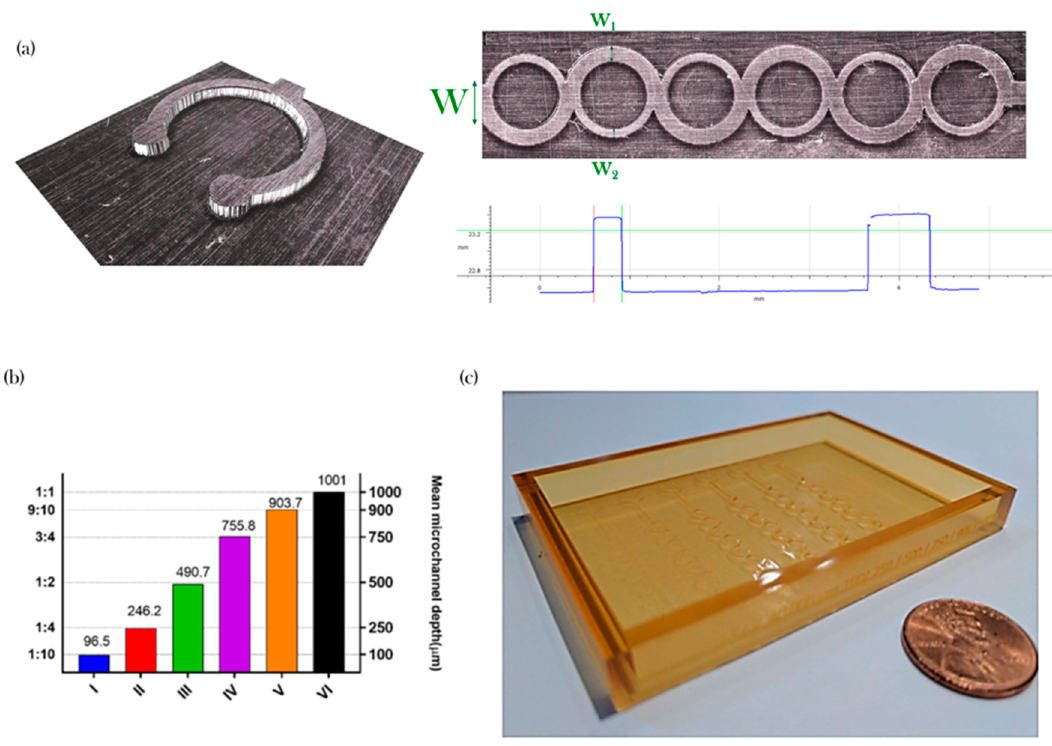
Figure 7. Micromixing device metrology; ( a ) Measurement of a key feature; ( b ) Mean microchannel pitch vs to width ratio and ( c ) Picture of an asymmetric split-and-recombine (ASAR) soft tool mold.